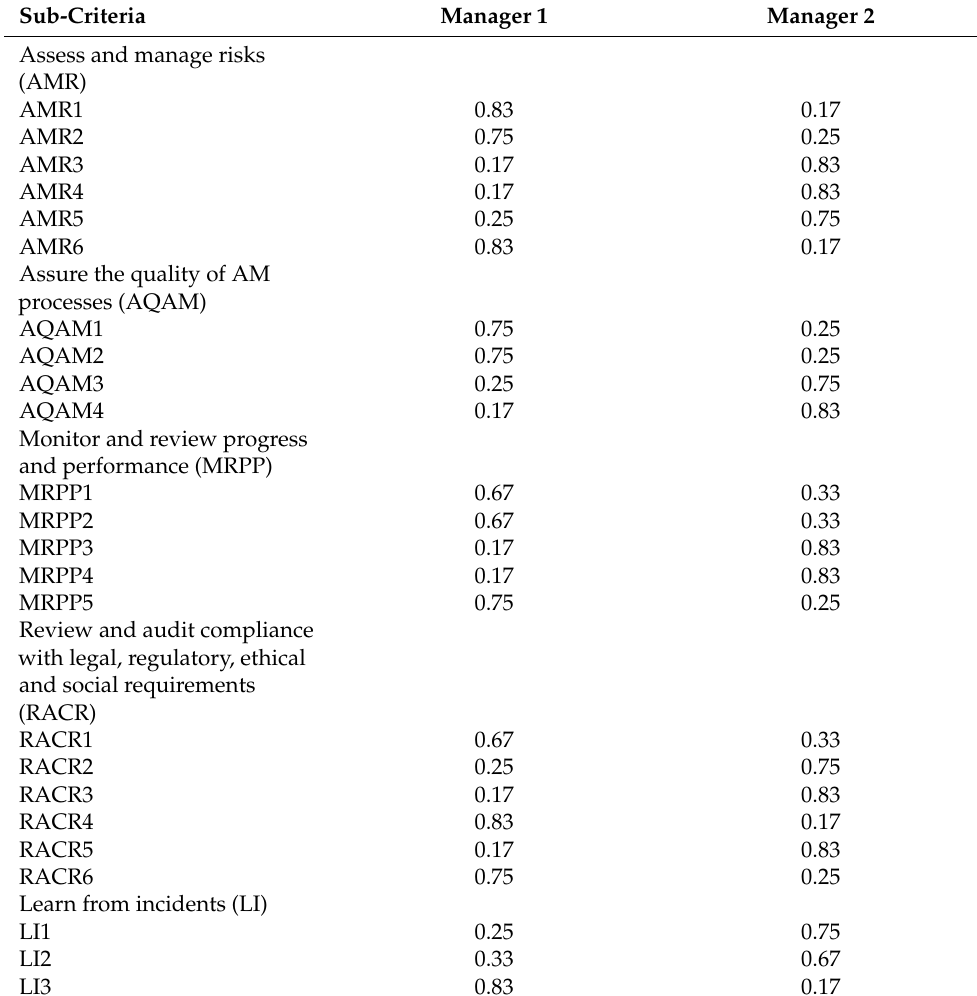
Table A3. The priorities for alternatives. Sub-Criteria Manager